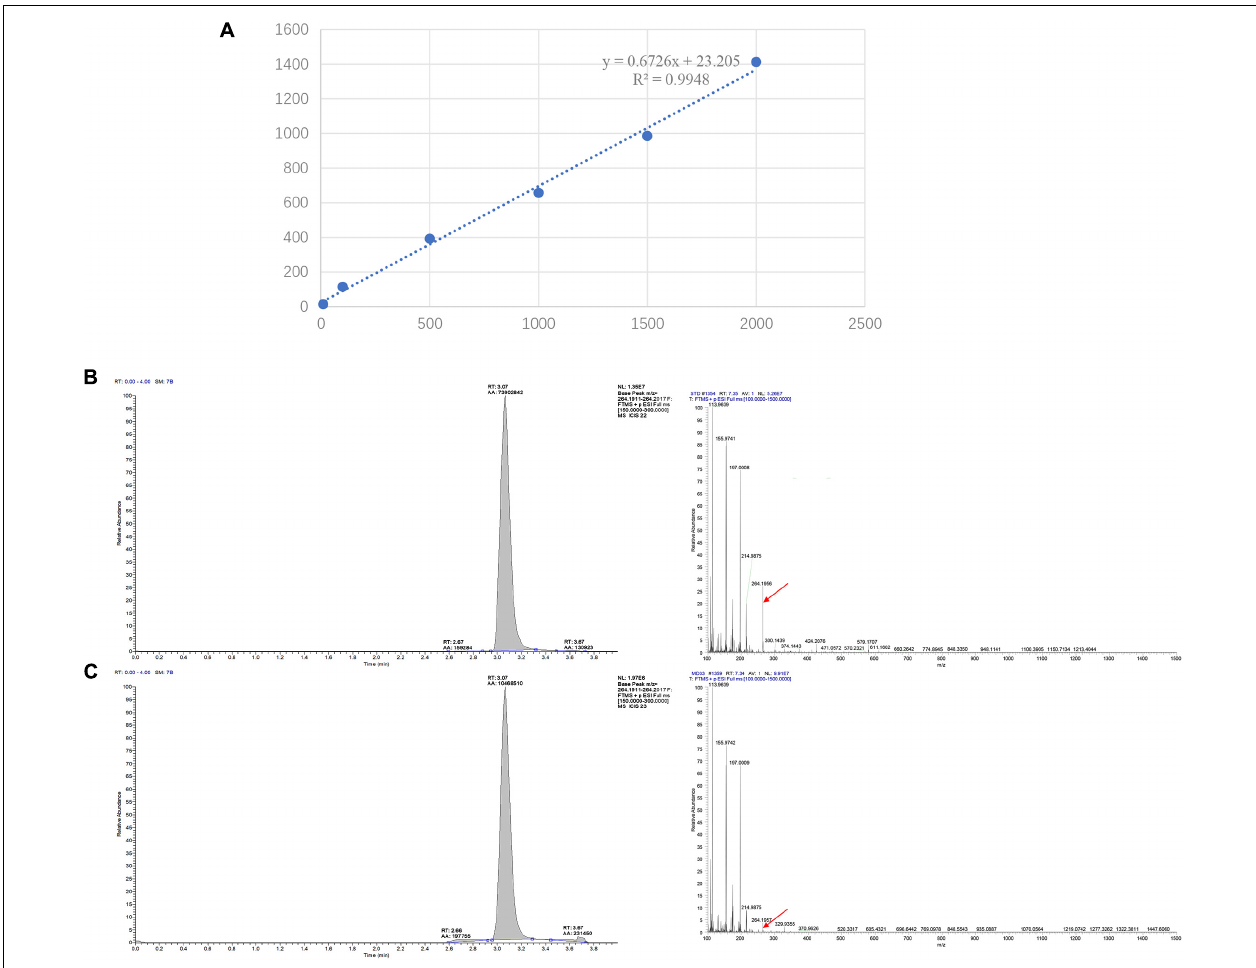
FIGURE 2 | LC-MS/MS chromatographs for the detection of dendrobine. (A) LC-MS detection standard curve of Dendrobine. The regression curve equation of dendrobine is y = 0.6726x + 23.205, R 2 = 0.9948. (B) T. longibrachiatum MD33 intracellular dendrobine. (C) Dendrobium nobile stem dendrobine (molecular weight: